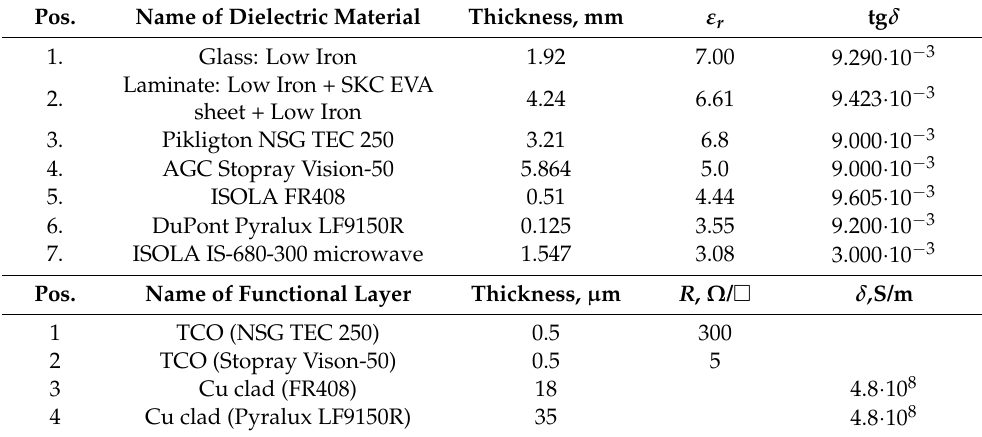
Table 1. Dielectric parameters of selected glass samples and transponder substrates.